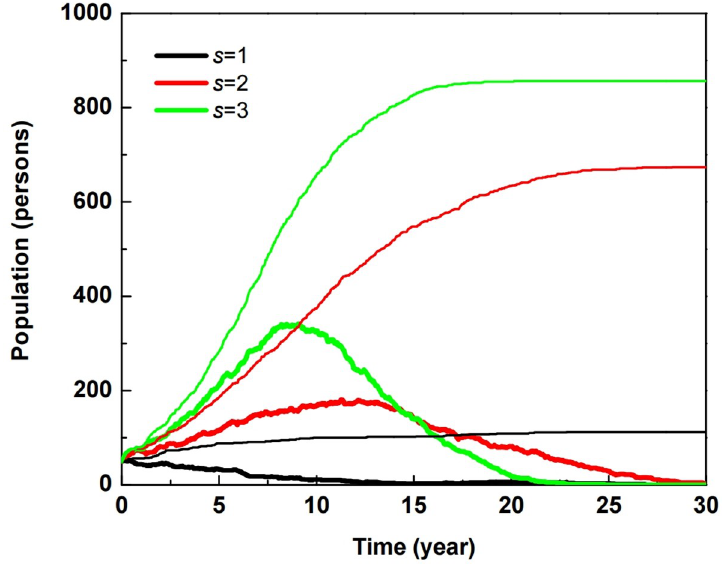
Fig 3. Population of church members (thin line) and passive believers (thick line) for disciple rate δ = 0.25, 0.33, and 0.5 in the ABM framework with sustainable potential s = 1 (S3